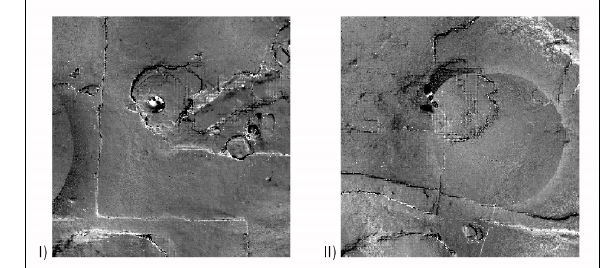
Figure 15 . Detail of the monochromatic rendering of the “difference image” resulting from the 3D model comparison between laser scanner and terrestrial DSLR Canon EOS 1200D of the first archaeological trench (apart of the vertical sides) during: (I) the first campaign (4/7/2019) and (II) the second campaign (19/7/2019) of the documentation of the excavation